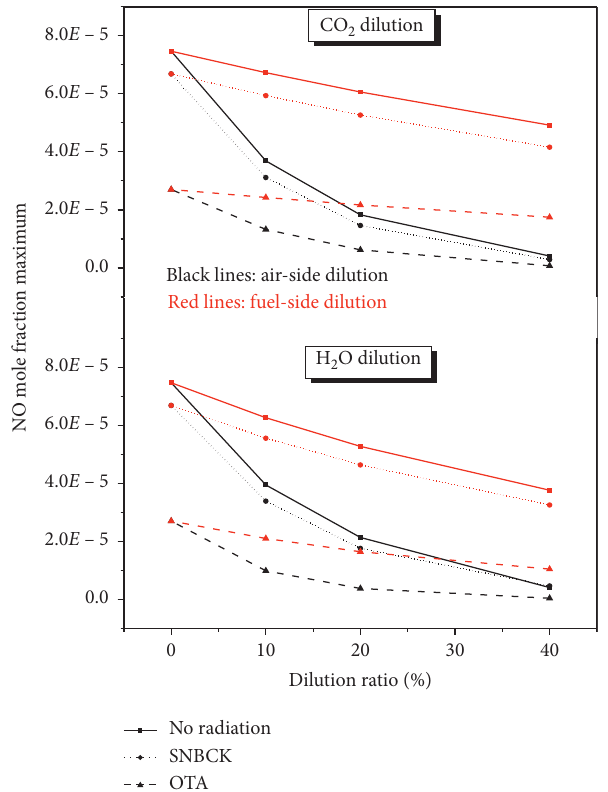
Figure 2: Variation of the peak NO mole fraction of CH counterflow diffusion flames with the dilution ratio by H 2 O and CO 2 dilution on the air and fuel side: a s � 50s − 1 , L � 2 cm,